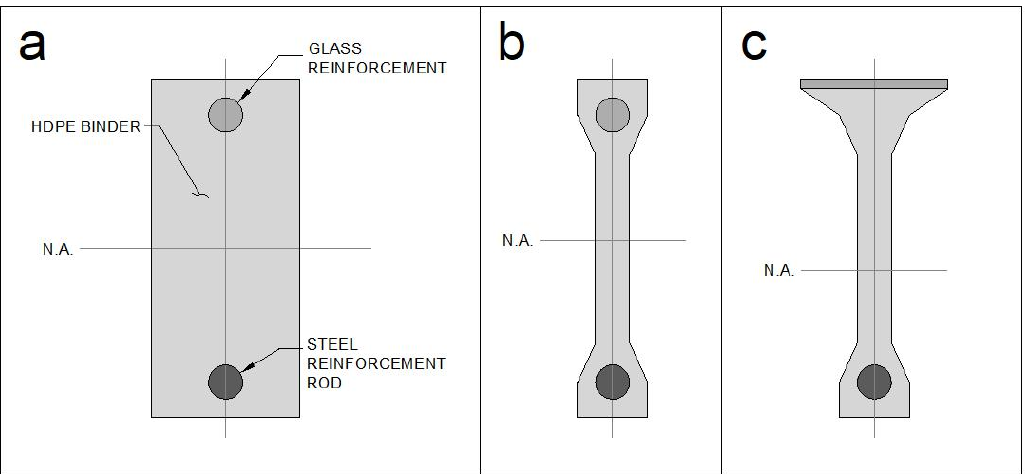
Figure 5. ( a ) The beams considered in this study, which feature a purposefully wide section to limit alternate failure modes. ( b ) An alternate design featuring rod-type reinforcement at the top and bottom. ( c ) Another alternative, but a sheet of glass is placed as top reinforcement.